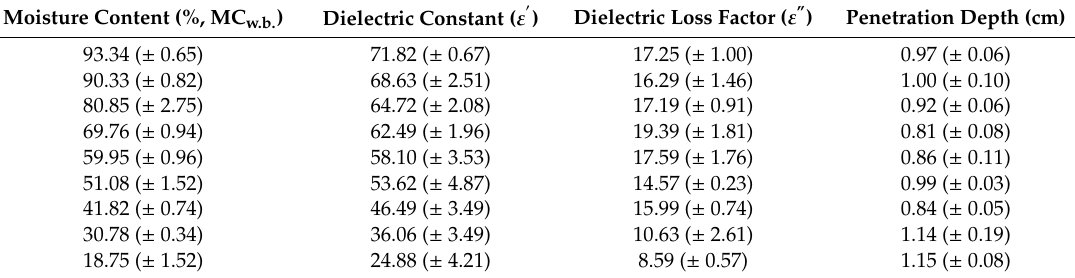
Table 4. Dielectric properties of radish depending on moisture content at 2450 MHz. Moisture Content (%, MC w.b.